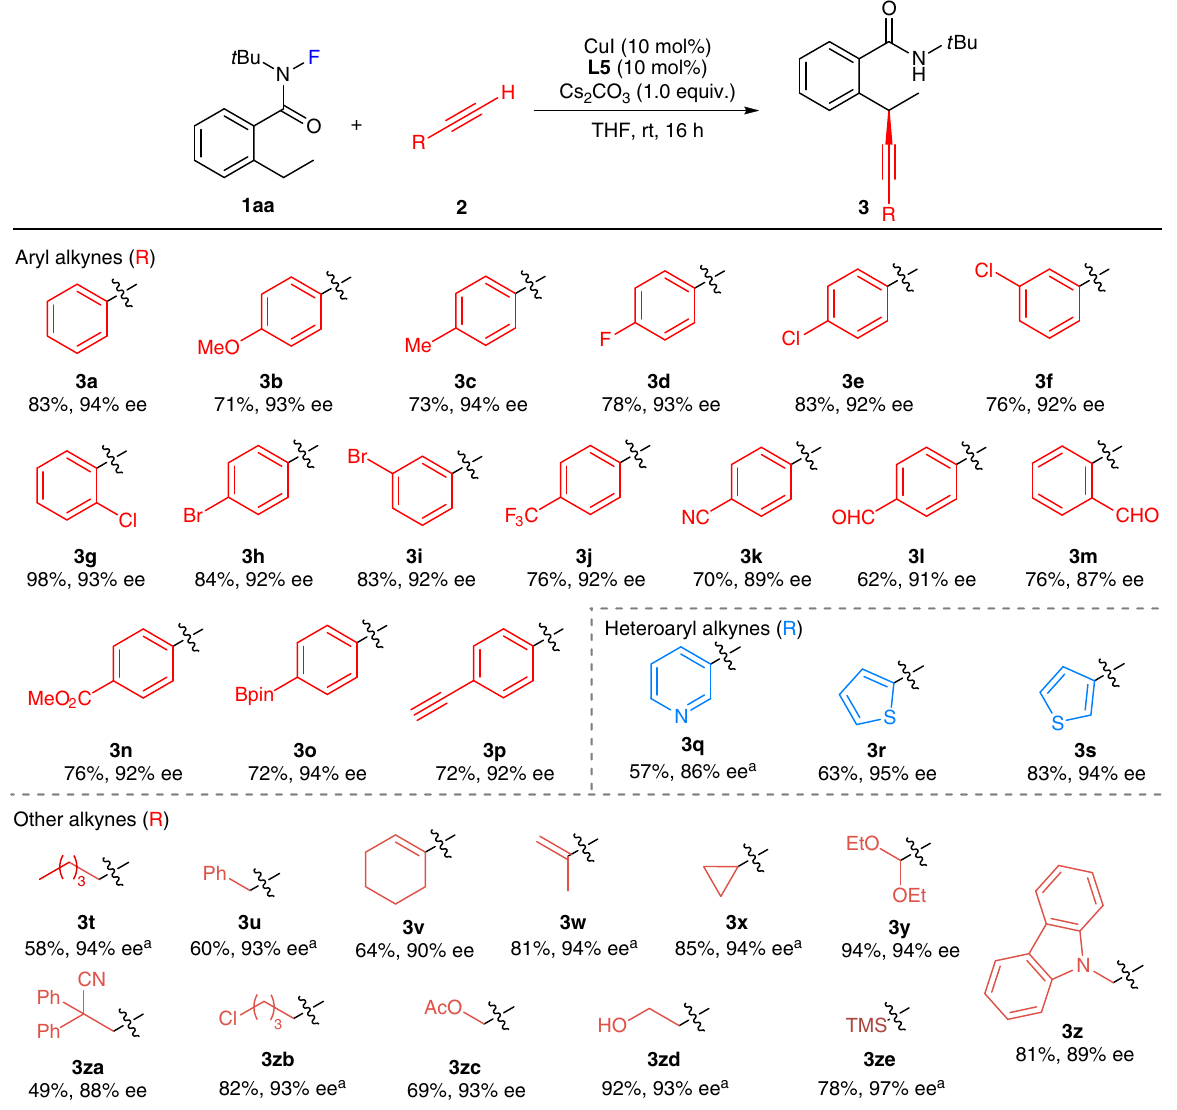
Fig. 2 Substrate scope of alkynes. Standard conditions: 1aa (0.2 mmol), alkyne (0.4 mmol), CuI (10 mol%), L5 (10 mol%), and Cs 2 CO 3 (1.0 equiv.) in THF (2.4 mL) at rt for 16 h. Isolated yield based on 1aa is given. Ee values are based on HPLC analysis. a CuTc (15 mol%), L5 (10 mol%), and Cs 2 CO 3 (2.0